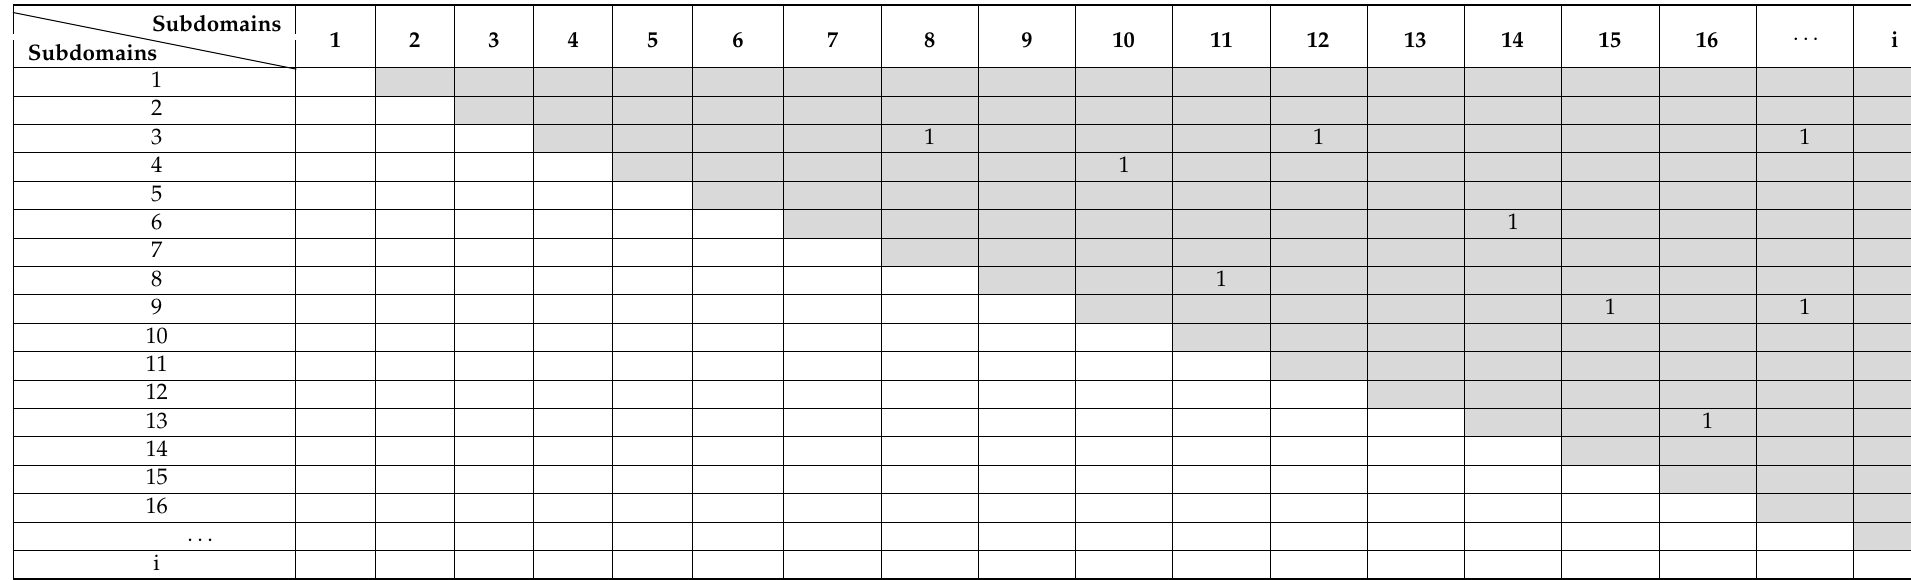
Table 7. Subdomains Relation Table (SRT) (To show that the algorithm only deals with upper side of the matrix which is highlighted in grey color).